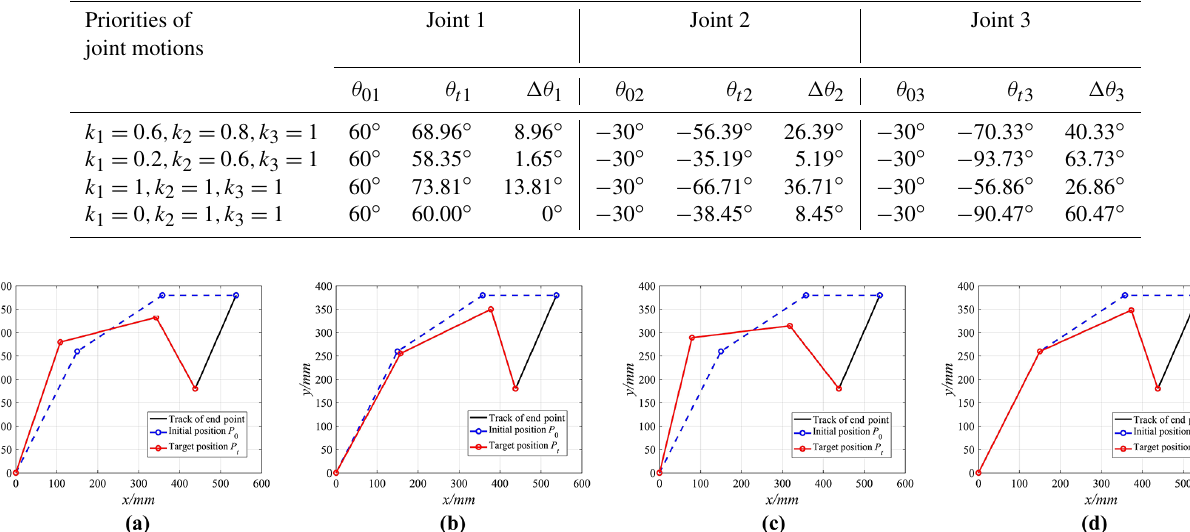
Figure 11. Motion trajectories of the manipulator with different motion priorities. (a) k 1 = 0 . 6, k 2 = 0 . 8, k 3 = 1 . 0. (b) k 1 = 0 . 2, k 2 = 0 . 6,